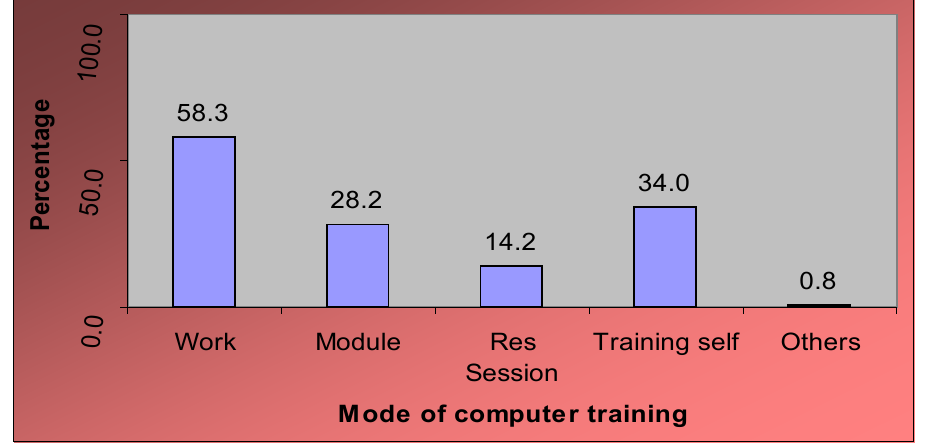
Figure 5 . How computer training was